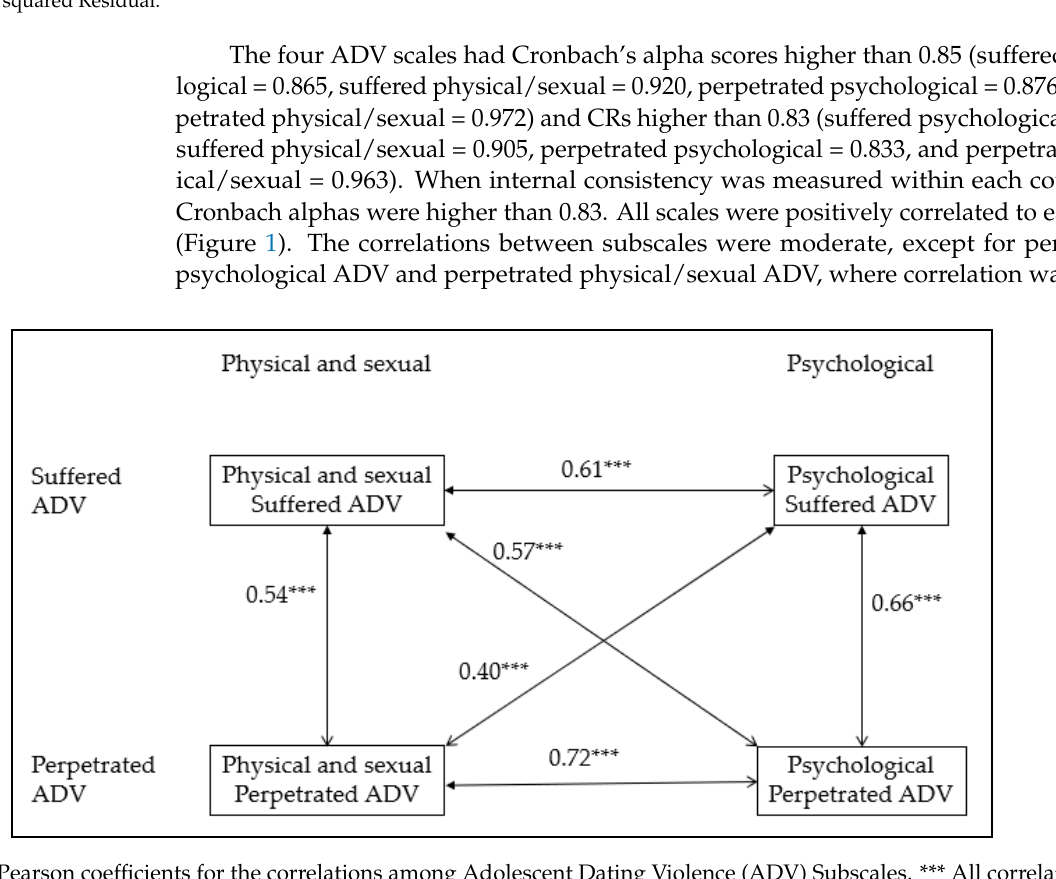
Figure 1. Pearson coefficients for the correlations among Adolescent Dating Violence (ADV) Subscales. *** All correlations were statistically significant ( p < 0.001)